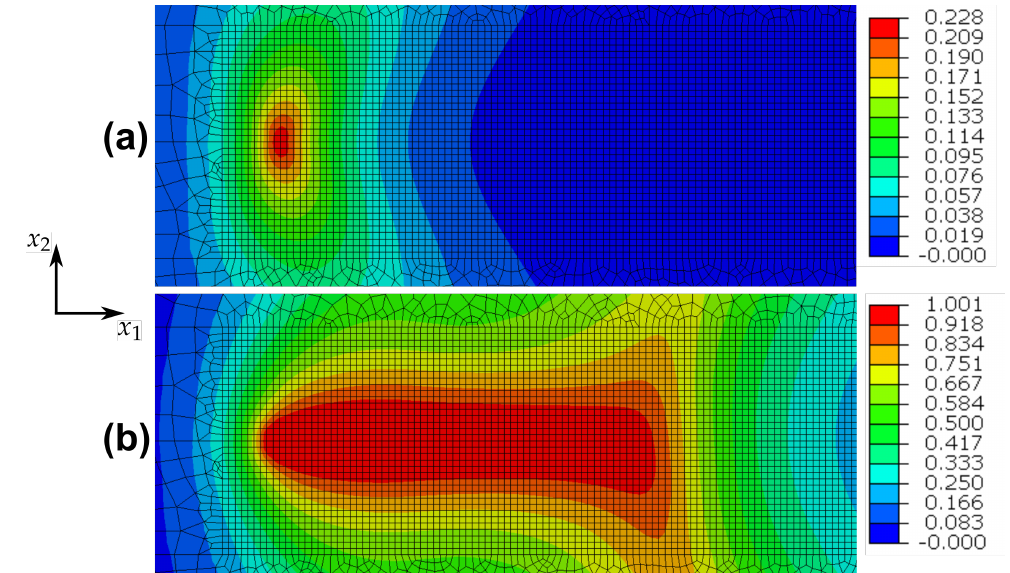
Figure 9. Pure isotropic hardening: damage evolution for the cracked specimen after ( a ) one loading cycle and after ( b ) ten loading